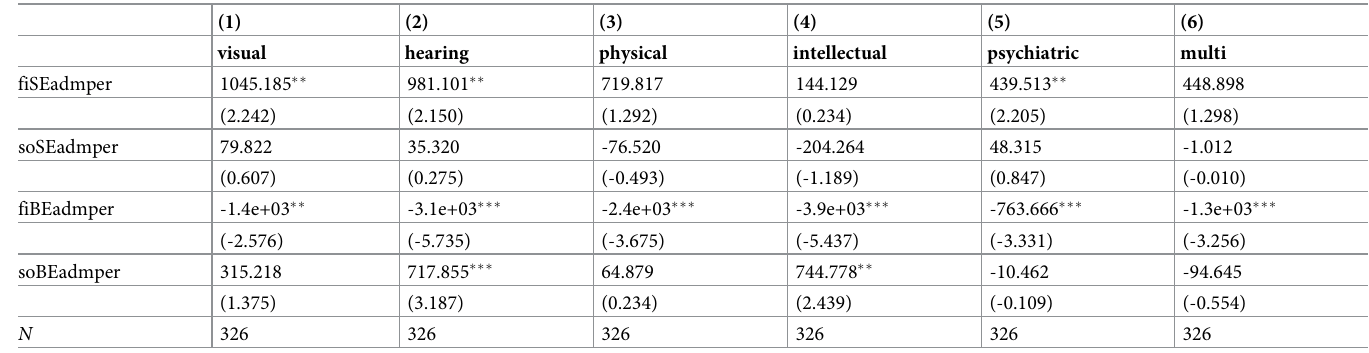
Table 8. The results of administrative expenditures on subtypes of RSE correction.